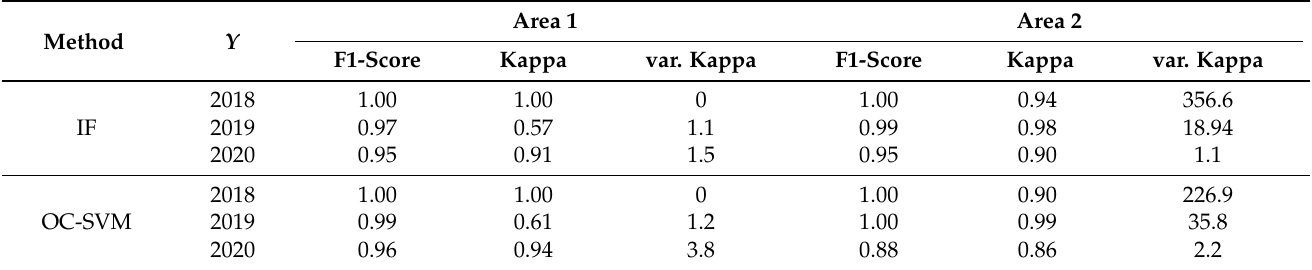
Table 2. Accuracy values summary. Variance of kappa scores are multiplied by 10 4